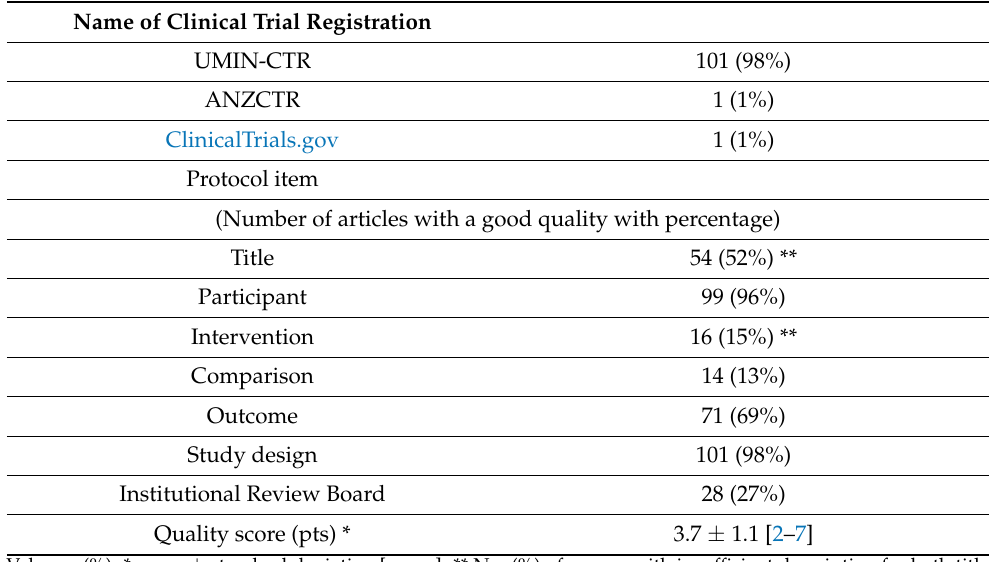
Table 1. Utilized clinical trial registration and protocol